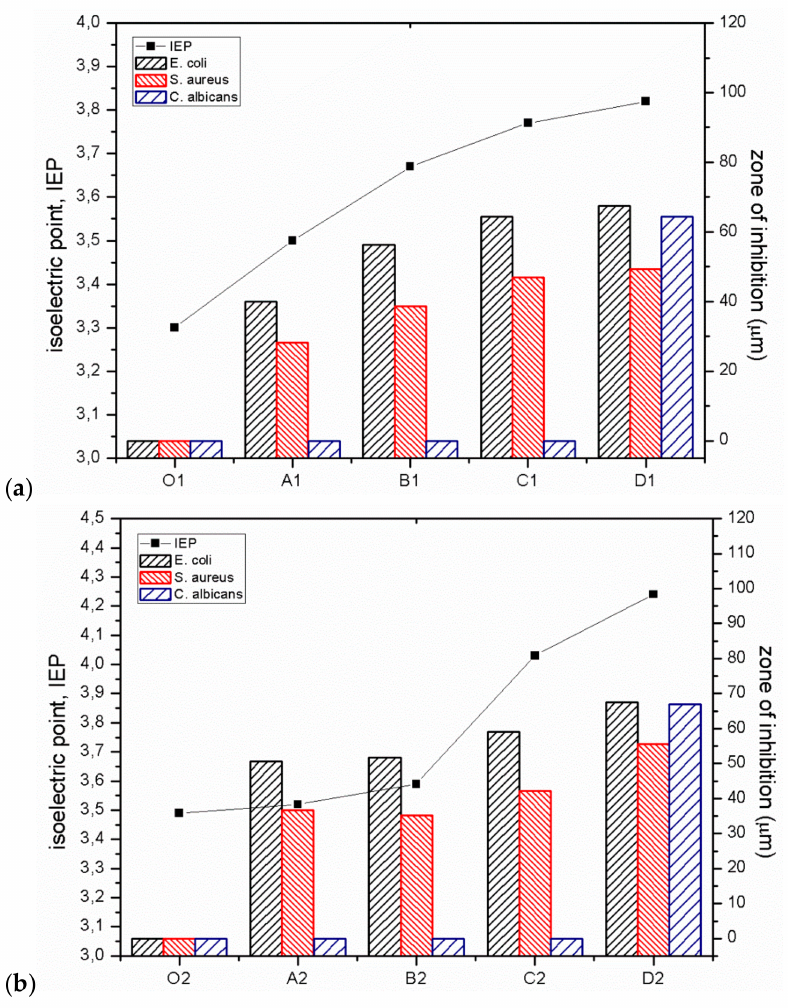
Figure 10. Antimicrobial activity (shown as the zone of inhibition) and IEP of CEL and GO/CEL fibres coagulated in water ( a ) and coagulated in methanol ( b ) on bacteria E. coli , S. aureus , and fungi C. albicans